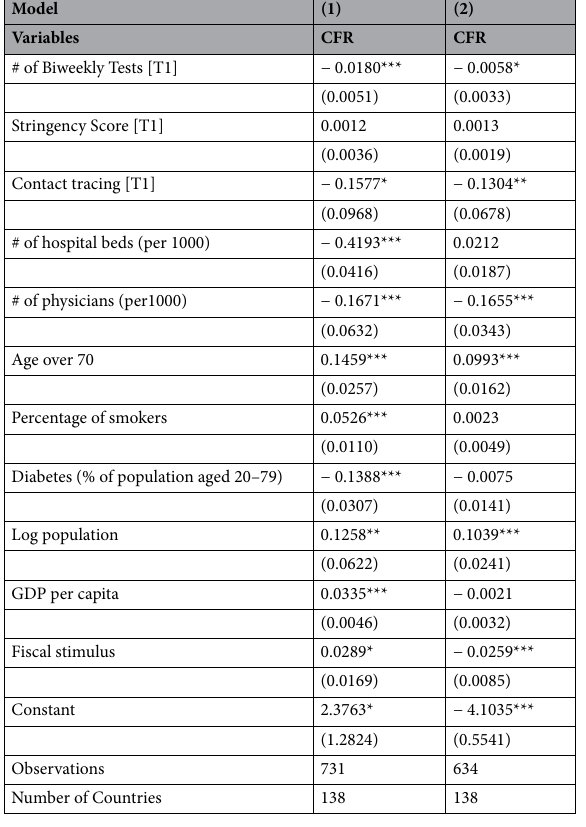
Table 2. Longitudinal data regression models for case fatality rates on time 2 [T2]. Robust standard errors in parentheses. We estimate Model 1 including outliers. Model 2 excludes outliers. ***p < 0.01, **p < 0.05, *p <